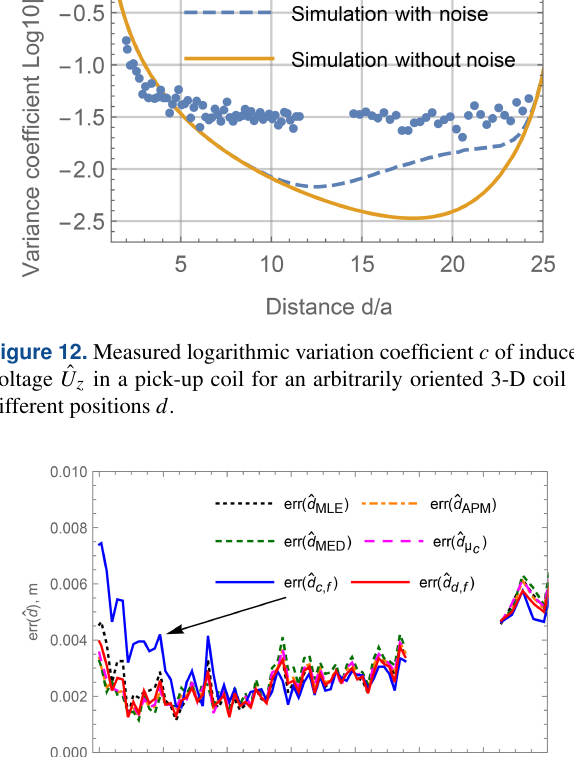
overlaid c Figure 13. Measured mean localization error at different positions d of five localization